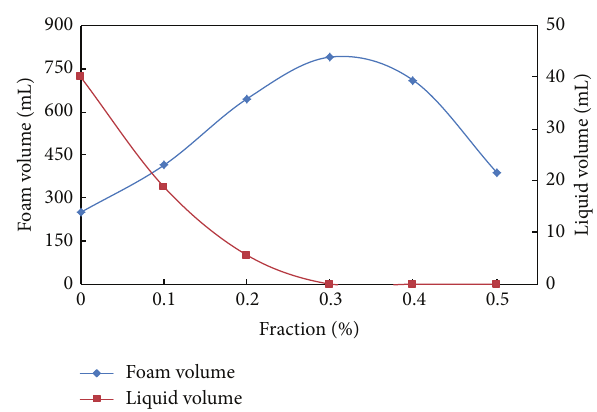
Figure 1: Gelation against the mass fraction of polymer blends.